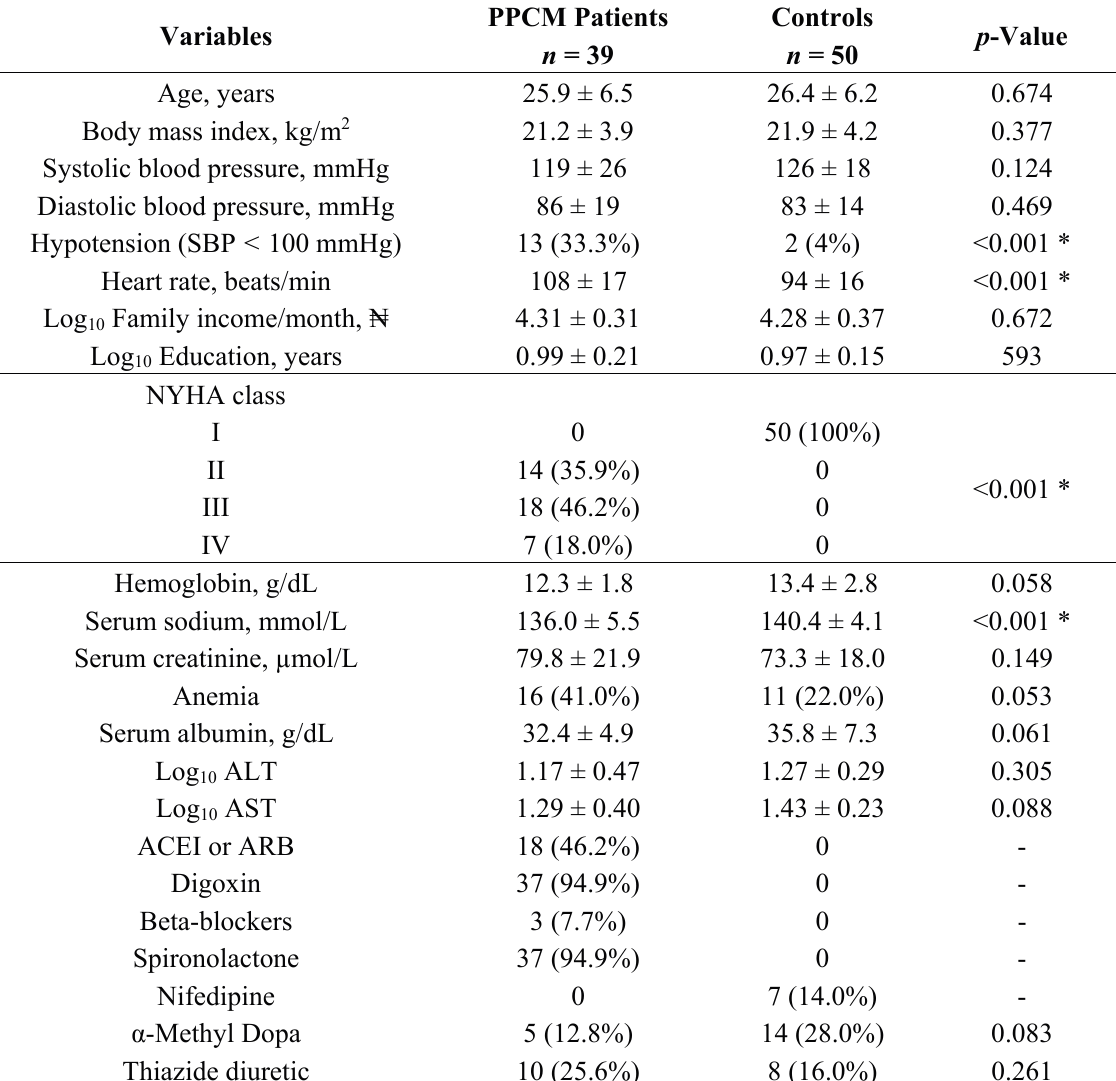
Table 1. Baseline characteristics of peripartum cardiomyopathy (PPCM) patients and